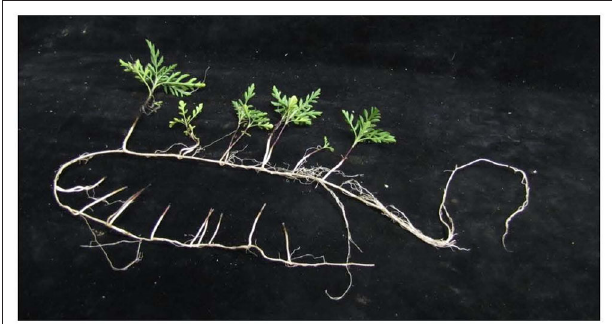
FIGURE 9 | Sprouts of a single A. confertiflora rhizome that developed from a plant grown in a tray in the summer in the net-house 121 DAS.